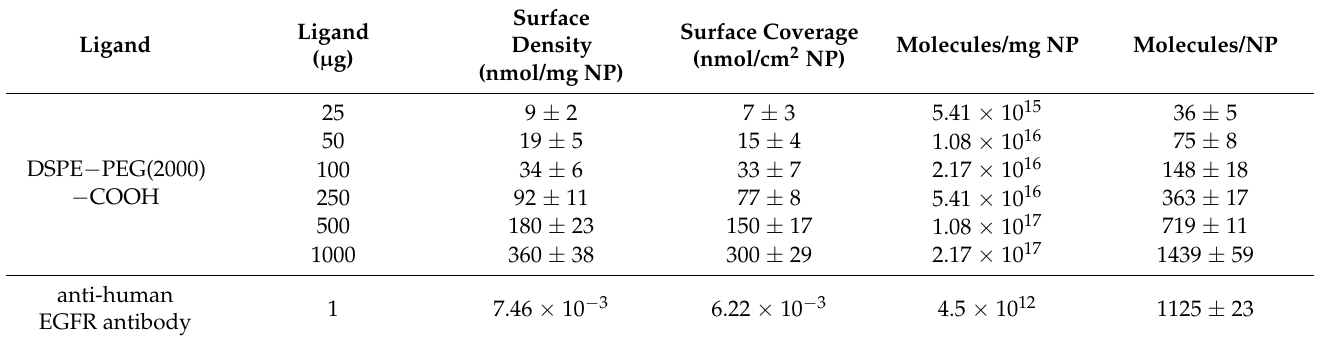
Table 1. Quantification of nanoparticle-bound ligands. The surface density of nanoparticles con- jugated with DSPE − PEG(2000) − COOH was measured at various ligand weights and anti-human EGFR antibody 1 µ g. The surface coverage, molecules/mg NP, and the molecules per NP were determined using surface area and density approximations for the spherical PLGA nanoparticles. Data represent mean ± standard deviation ( n = 3).